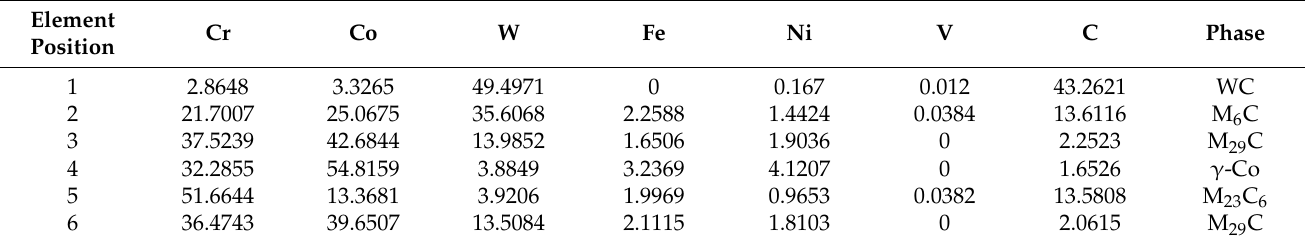
Table 3. The EPMA result of phases in the Co–Cr–W matrix composites (at.